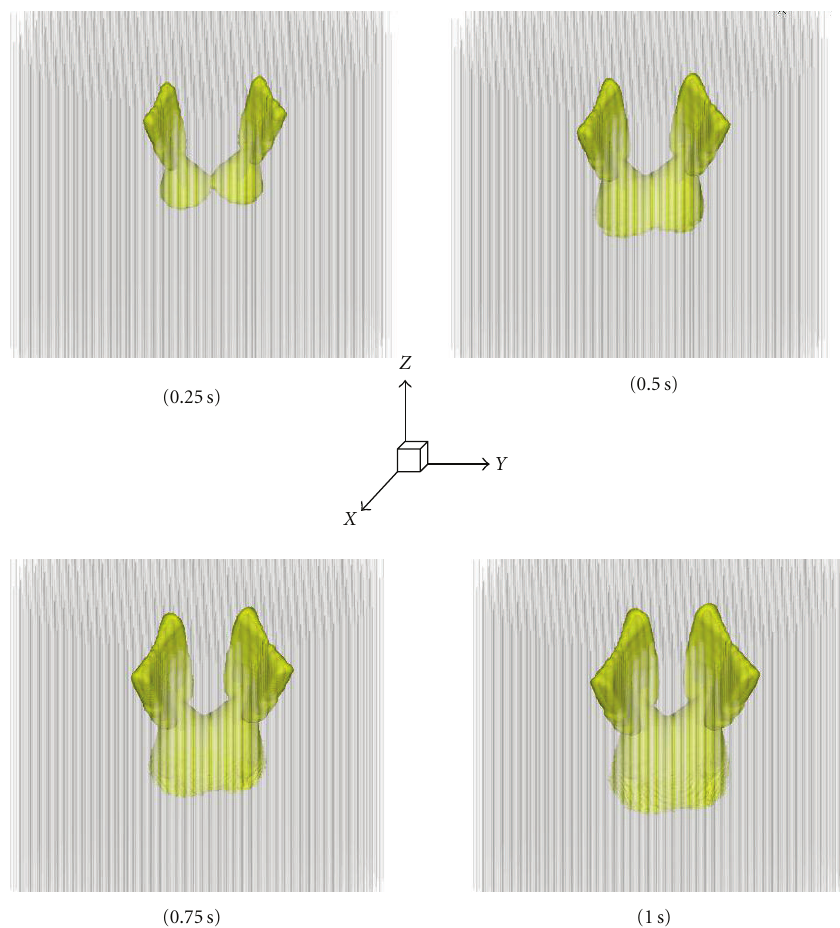
Figure 12: Iso-surface of two boron